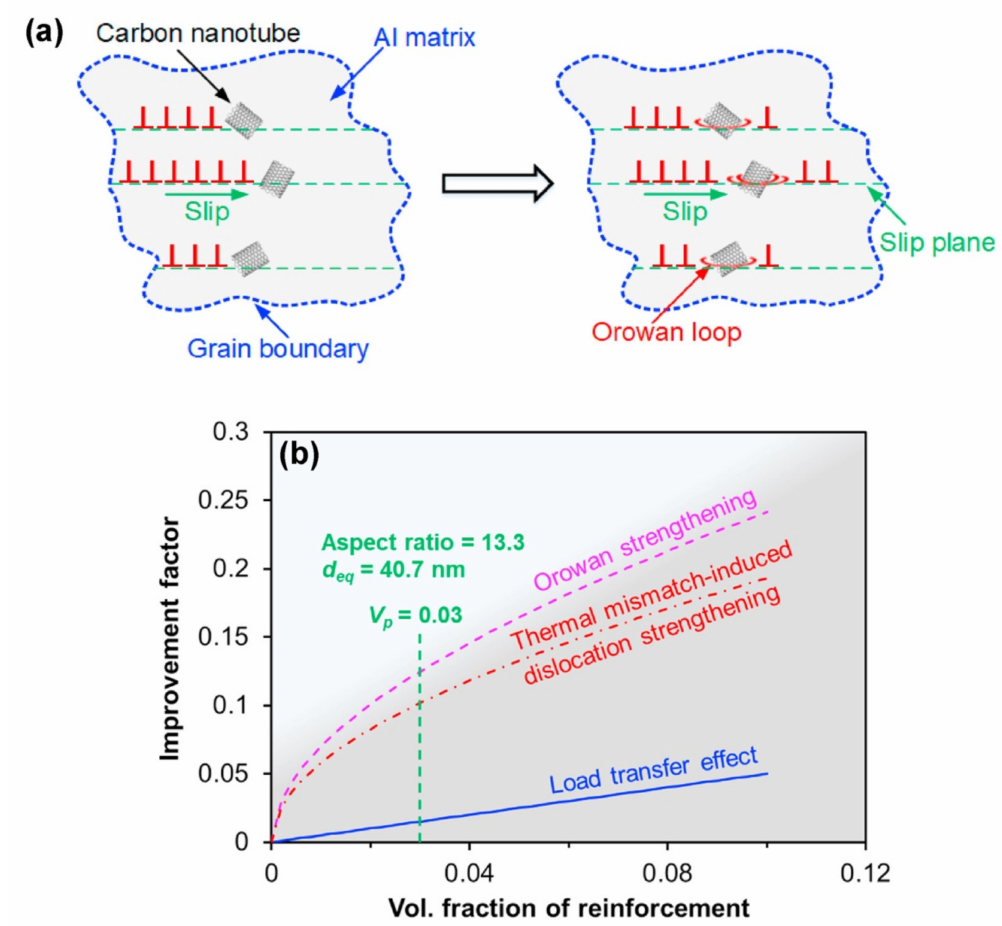
Figure 22. ( a ) A schematic showing the Orowan looping mechanism after dislocations gliding over and bypassing the CNTs, and ( b ) the individual contribution of the strengthening mechanisms in the nanocomposite as a function of volume fraction. Reproduced from [106] with permission from Elsevier,